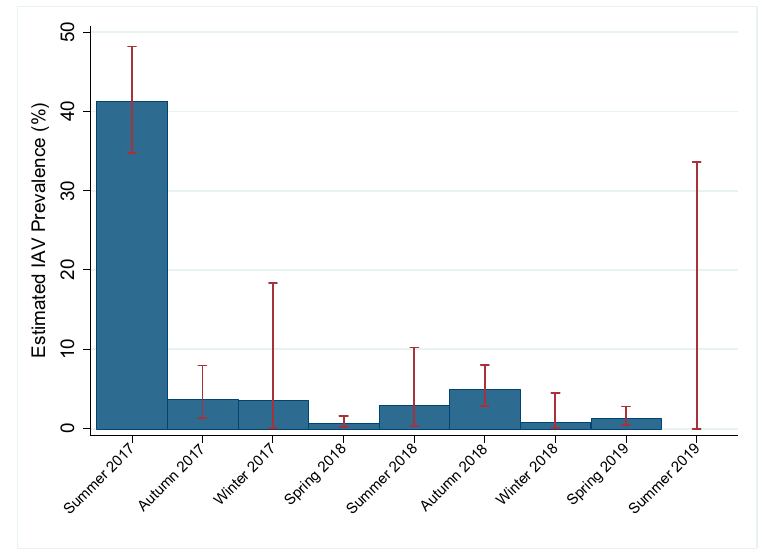
Figure 2. Estimated influenza A virus (IAV) prevalence in migratory mallards near Port Clinton, Ohio, USA by season. Year-round, active IAV surveillance in mallards ( Anas platyrhynchos ) was conducted for two years (July 2017–July 2019) in one location to fill a gap during spring migration and resulted in 2096 cloacal swabs. Viral isolation was attempted on all real-time reverse transcription polymerase chain reaction positive and undetermined samples. Prevalence was estimated by the proportion of viral isolates and the number of cloacal swabs collected during each season expressed as a percentage. Estimated IAV prevalence of mallards at the study location for each season of the study period is shown by blue bars with 95% confidence intervals shown by red error bars. Summer: June–August; autumn: September–November; winter: December–February; spring: March–May. Table 1. Influenza A virus (IAV) subtypes recovered from wild mallards near Port Clinton, Ohio, USA by season. Active IAV surveillance in wild mallards ( Anas platyrhynchos ) was conducted year- round July 2017–July 2019 in an attempt to fill a gap in surveillance during the spring season. IAV subtypes isolated from mallards are shown by season. Both pure and mixed subtypes were isolated throughout the study period.